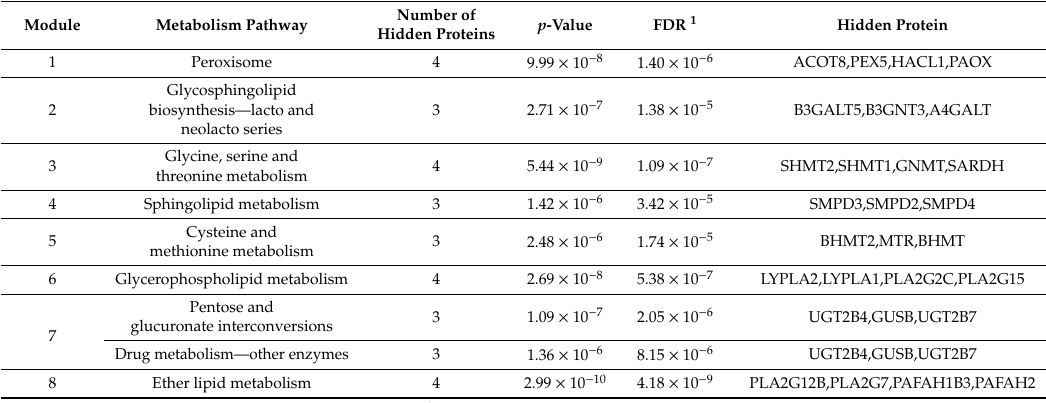
Figure 5. Altered metabolic pathways identified by PIUMet. Table 5. Altered metabolism pathways identified in the hair from heavy MA